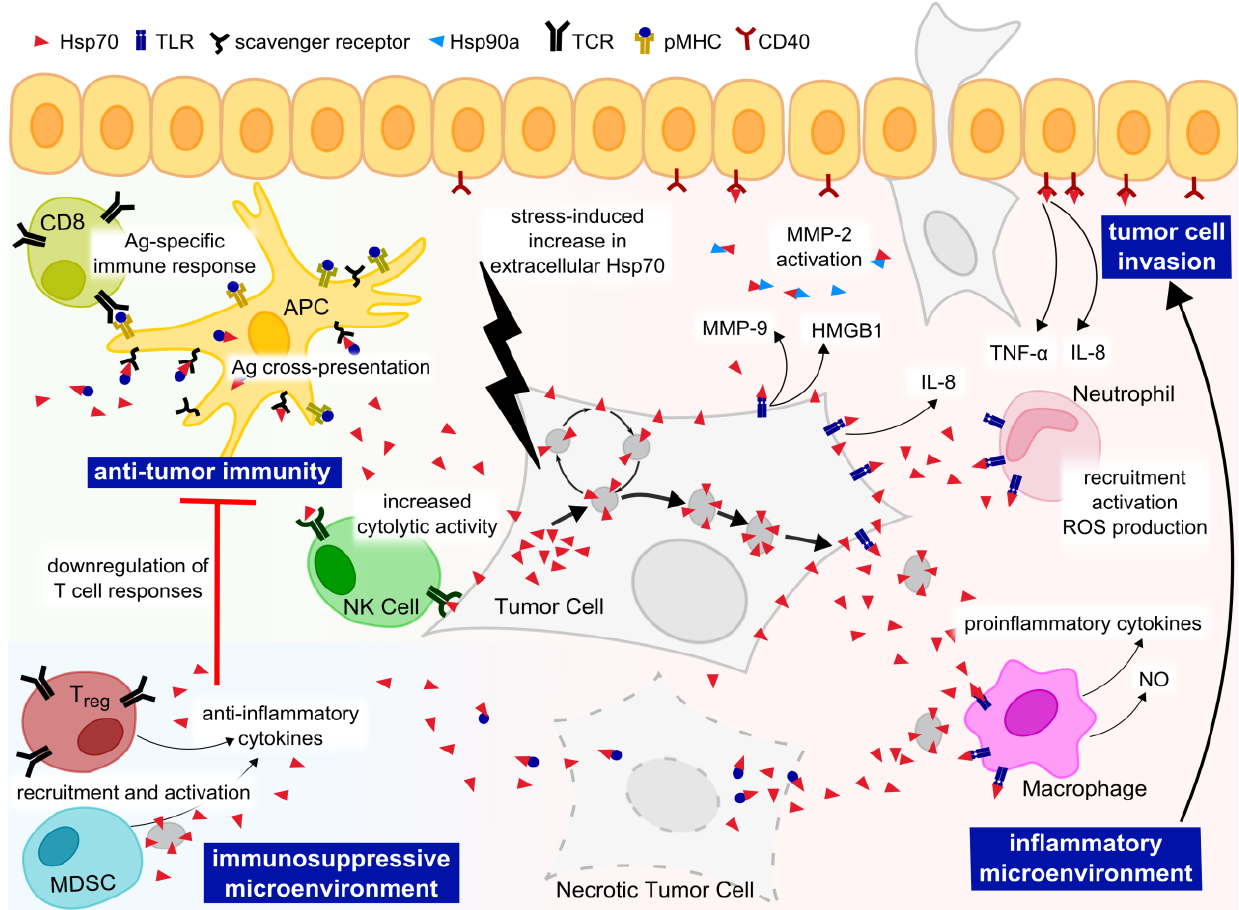
Figure 3. Versatile functions of extracellular Hsp70. Extracellular Hsp70 is able to interact with receptors expressed on cells of the tumor microenvironment. Hsp70 complexed to tumor-derived peptide binds to scavenger receptors on antigen presenting cells (APC), and is internalized and cross-presented to CD8 + T cells, thereby an adaptive tumor-specific immune response is initiated. Stimulation of NK cells by Hsp70 leads to increased cytotoxic activity against Hsp70-positive tumor cells. Hsp70 has an immunosuppressive role via recruitment and activation of regulatory T cells (Treg) and myeloid-derived suppressor cells (MDSC), leading to the downregulation of T cell responses. Hsp70 acts as a danger signal via binding to Toll-like receptors (TLRs) on mononuclear cells, leading to secretion of pro-inflammatory cytokines and nitric oxide (NO), in turn providing an inflammatory environment that contributes to metastasis formation. Hsp70 promotes tumor invasion and angiogenesis through activation of MMP-2 and production of ROS by neutrophils, respectively. Binding of Hsp70 to epithelial cells results in secretion of pro-inflammatory cytokines, activating an amplification